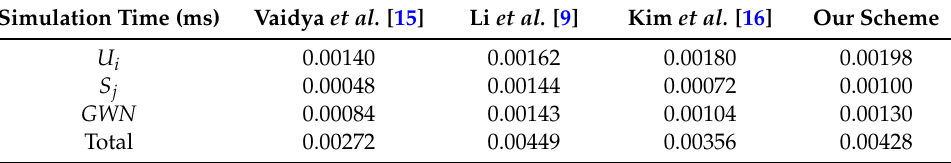
Table 3. The simulation comparisons of related schemes and the proposed scheme.